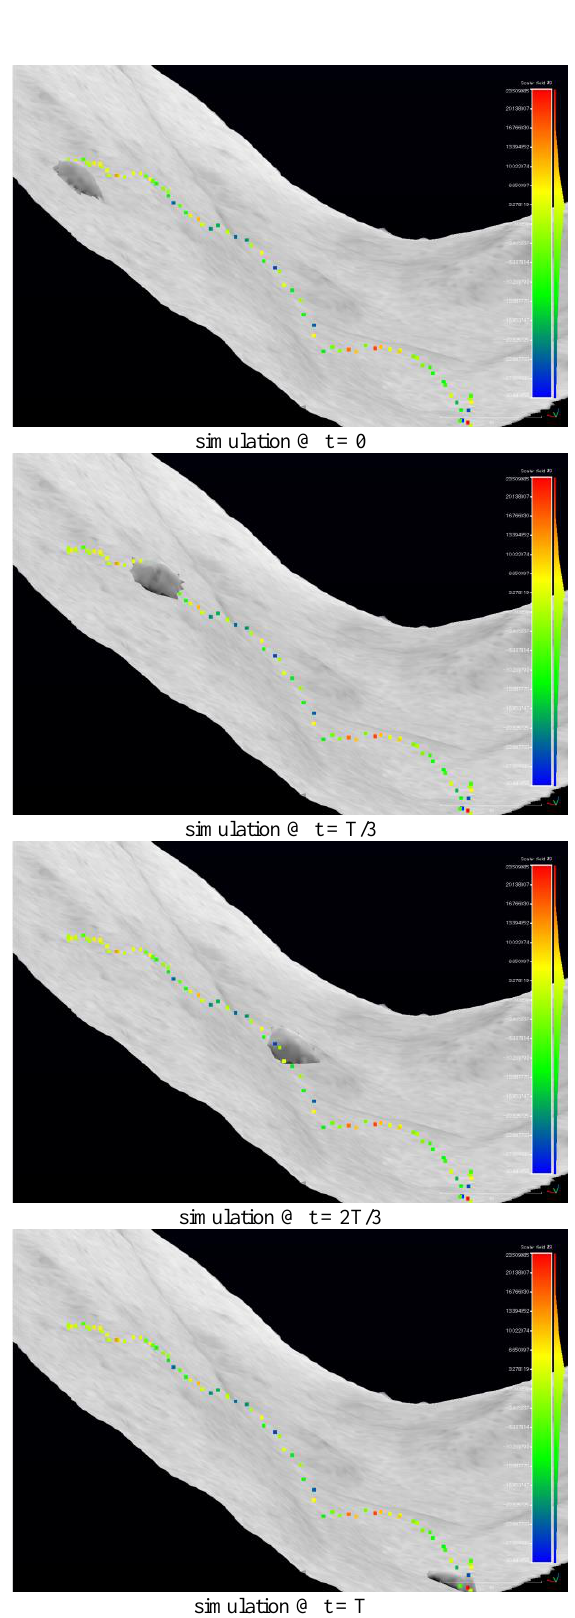
Figure 5. Rock-fall simulation (T = 7 sec)